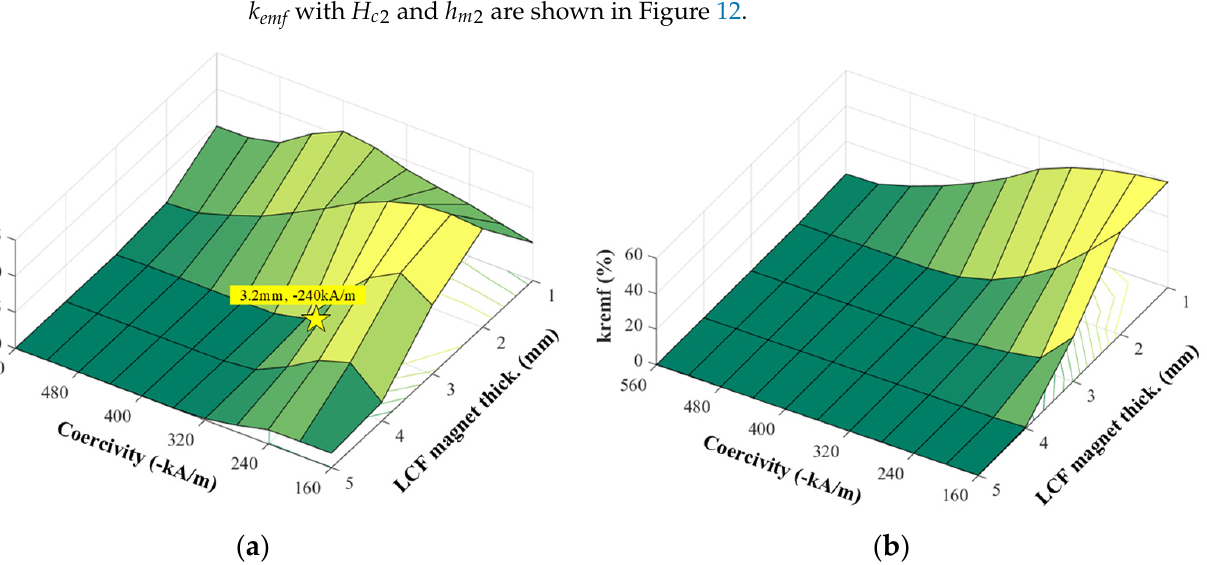
Figure 13. Flowchart of the procedure of the magnet optimization.